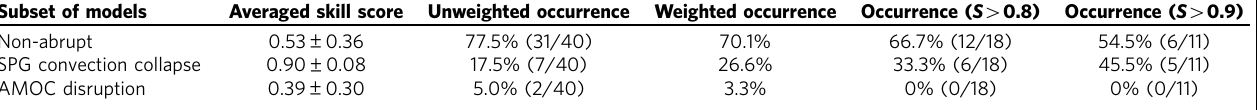
Summary of the averaged skill scores featured by the different sub-ensembles. The probability of occurrence of the event associated with each subset of models is shown, respectively, if no weighting criterion is applied to the models, if a weighting criterion is applied to the models, if only models satisfying the condition S 4 0.8 are considered, if only models satisfying the condition S 4 0.9 are